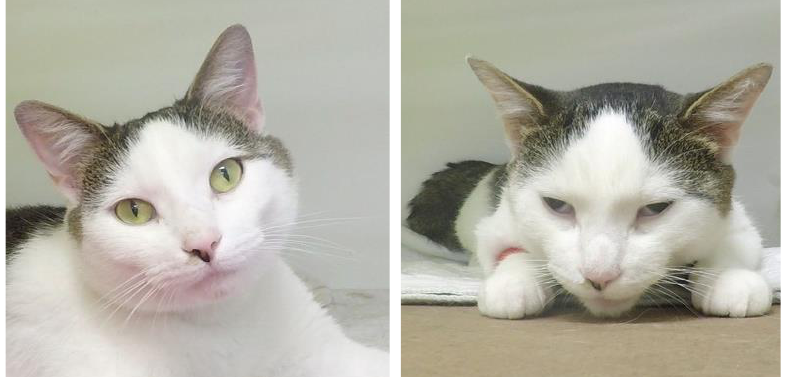
Figure 3. Example of changes in facial expressions in one cat before ( left ) and 20 min after ( right ) sedation with dexmedetomidine and butorphanol.